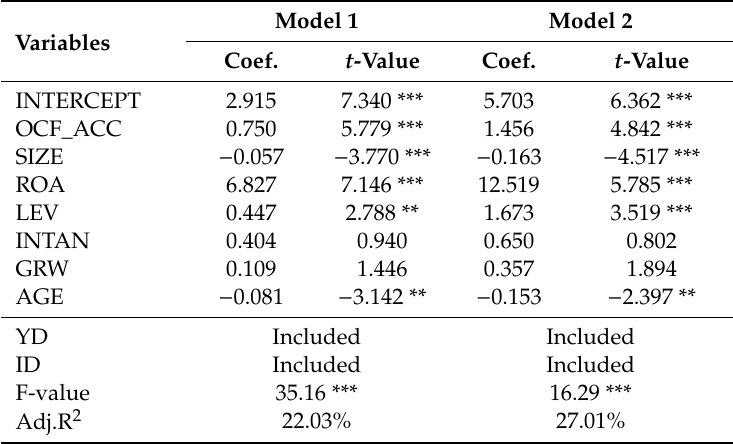
Table 8. Analysts’ cash flow forecasts accuracy and firm